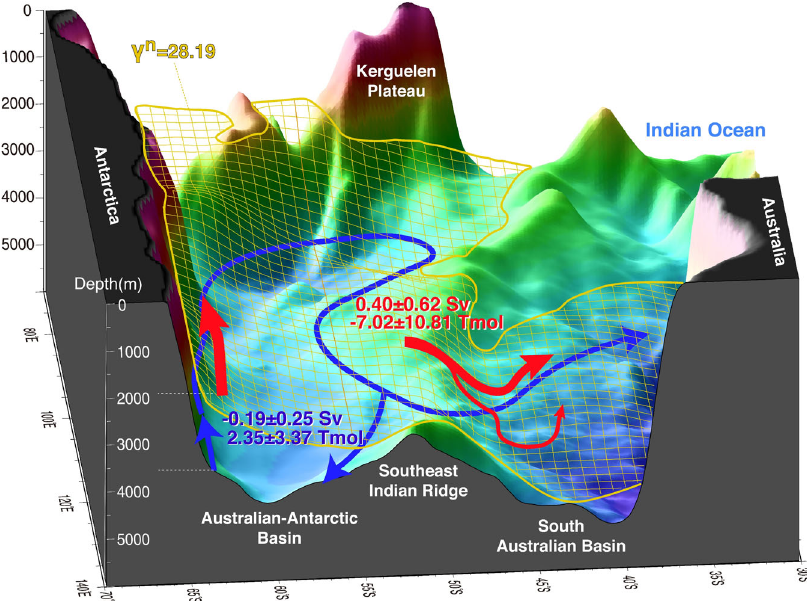
Fig. 6 Three-dimensional schematic of pathways for the densest and less dense layers of the Lower limb of the meridional overturning circulation (LMOC). The pathway in the densest layer of LMOC (densest LMOC) is shown by blue arrows and the pathways of intensi fi ed ventilation in less dense layers of LMOC (less dense LMOC) are schematised by red arrows. A meshed surface indicates a climatological isopycnal of γ n = 28.19 kg m − 3 , estimated using data obtained at WOCE/GO-SHIP sections SR3, I09s, and I08s, with a previously proposed interpolation scheme 32 . The narrow pathway on less dense LMOC in the eastern South Australian Basin (SAB) re fl ects the fact that the observed density at the SR3 section (located from 140 – 147° E) is lower than the meshed isopycnals and that the apparent oxygen utilisation (AOU) decrease can be observed in the less dense layer above γ n = 28.18 kg m − 3 . Total AOU changes in the densest LMOC ( γ n > 28.32 kg m − 3 for the Australian Antarctic Basin and γ n > 28.19 kg m − 3 for the SAB) and less dense LMOC are shown, along with required changes in Dense Shelf Water